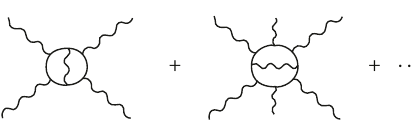
Figure 2 . Feynman diagrams contributing to the 2-loop